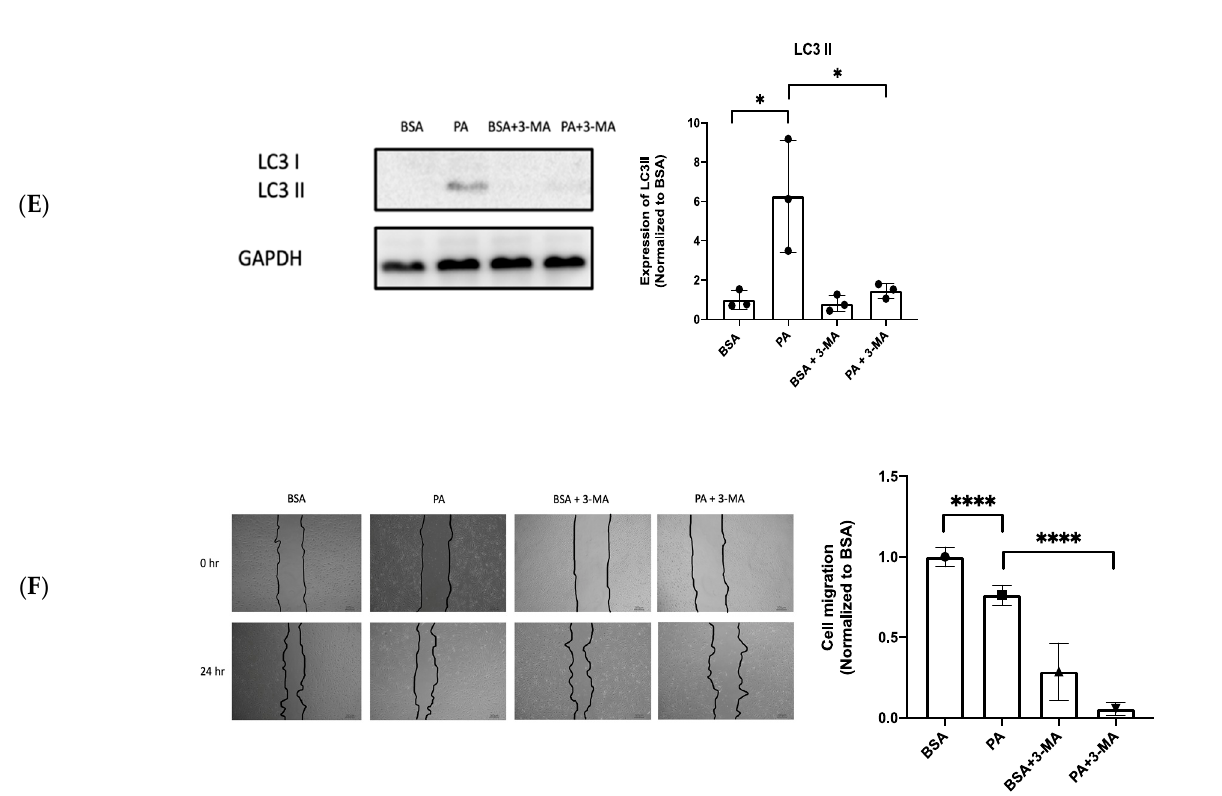
Figure 4. XBP1 protects endothelial cells from lipotoxicity by regulating autophagy. Autophagy induced by PA was analyzed using Western blotting and quantified. The protein expression of ( A ) LC3 II/I after the co-treatment of PA and 4u8c; ( B ) LC3 II/I, p62 after the silencing of XBP1s, ( C ) beclin-1, ( D ) ATG5, and ( E ) LC3 II/I after co-treatment with PA and 3-MA; and ( F ) wound healing assay after combined treatment with PA and 3-MA. Data are presented as the mean ± SEM, and the images are representative of three independent groups. Data from multiple groups were analyzed by one-way ANOVA, followed by Tukey’s post hoc test. * p < 0.05, *** p < 0.001, **** p < 0.0001, respectively. ns: not significance.